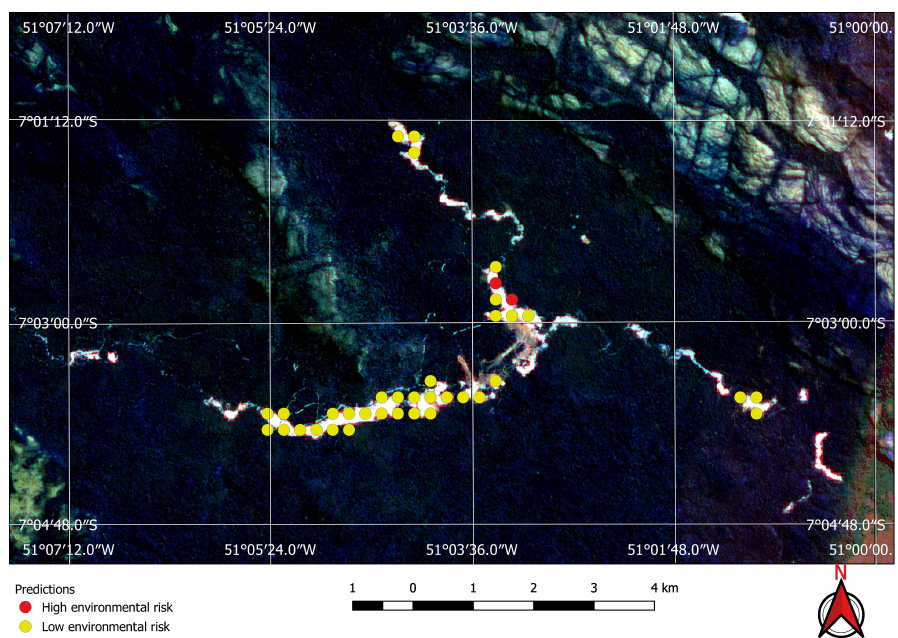
Figure 22. True positives on Kayapo’s protected land visible on Sentinel 2